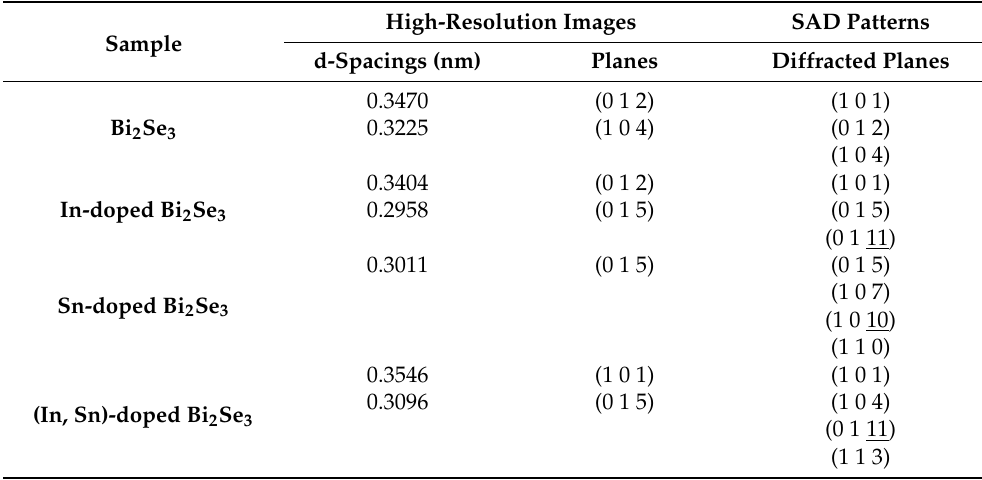
Figure 3. HRTEM images and SAD patterns of ( a ) Bi 2 Se 3 , ( b ) In-, ( c ) Sn-, and ( d ) (In, Sn)-doped Bi 2 Se 3 nanoplatelets. Table 3. The d-spacings and diffracted planes of pristine, and In-, Sn-, and (In, Sn)-doped Bi 2 Se 3